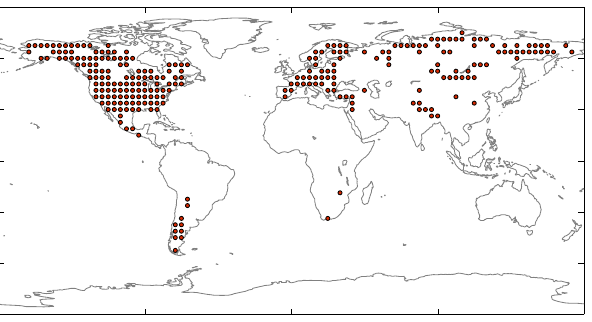
Figure 2. Station set resembling real TRW network from Breiten- moser et al.